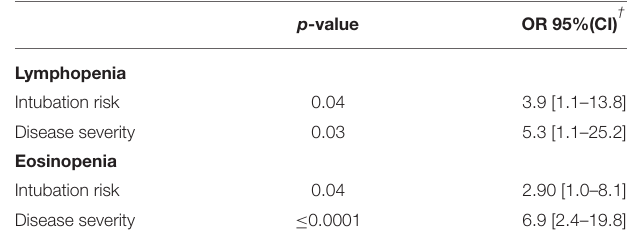
TABLE 2 | Association between hematological abnormalities with demographic TABLE 3 | Independent associations between eosinopenia and lymphopenia with characteristics and COVID-19 related outcomes. intubation risk and higher severity scores following adjustment for age and sex in a multivariate logistic regression p -value Anemia Normal or elevated Hb levels